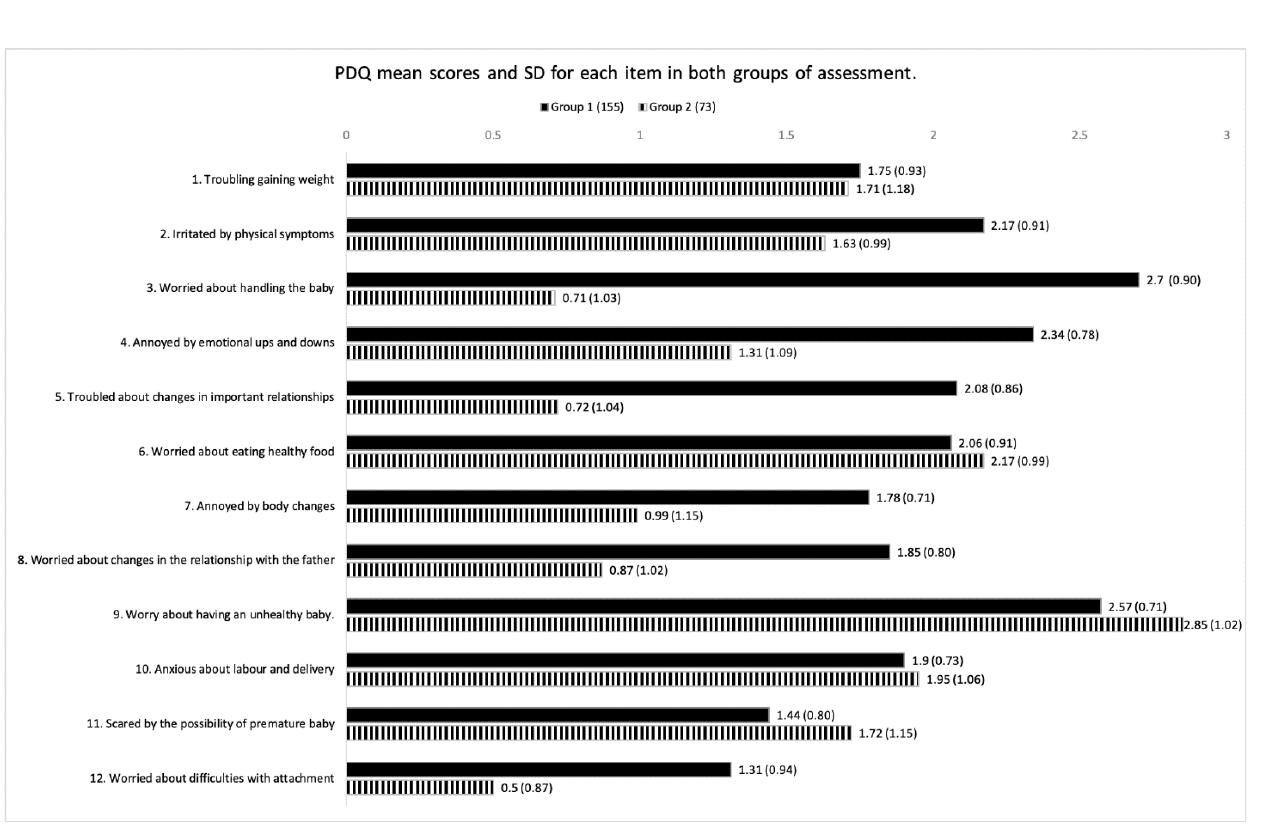
Figure 1. PDQ mean scores and standard deviations (in brackets) for each item in both groups. Group 1 (face to face); Group 2 (on-line).